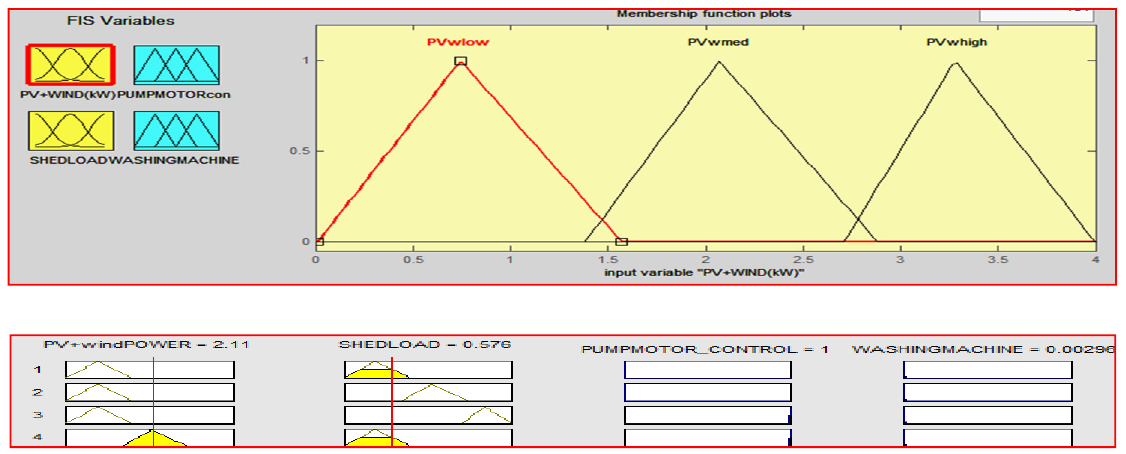
Figure 14. Schedulable load membership function and its fuzzy ON&OFF control.